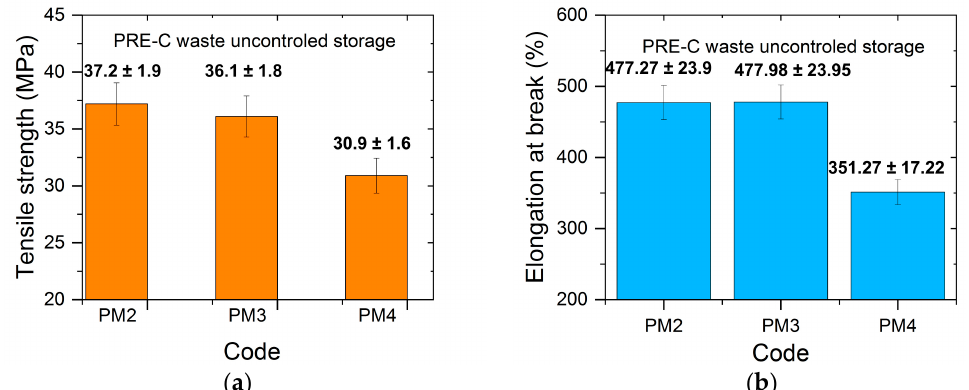
Figure 11. The mechanical properties of films with mechanically recycled compound content (PM2, PM3) from PET-CW stored in uncontrolled conditions (( a ) Tensile strength at break; ( b ) elongation at break).